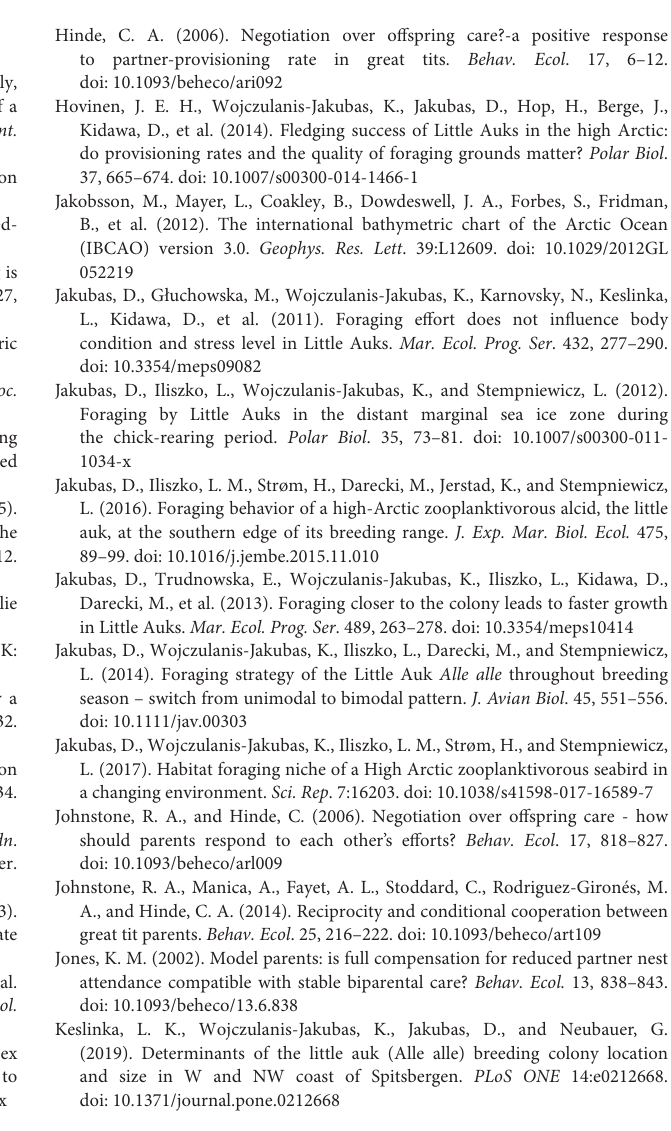
Table S1 | Detailed information on abiotic data used in analyses, and dates of data collection. Table S2 | Coordination and environmental data. Figure S1 | Environmental conditions during the studied breeding seasons ( A : the ratio of Calanus glacialis / Calanus finmarchicus abundance; B : Simpson’s Diversity Index; C : Sea Surface